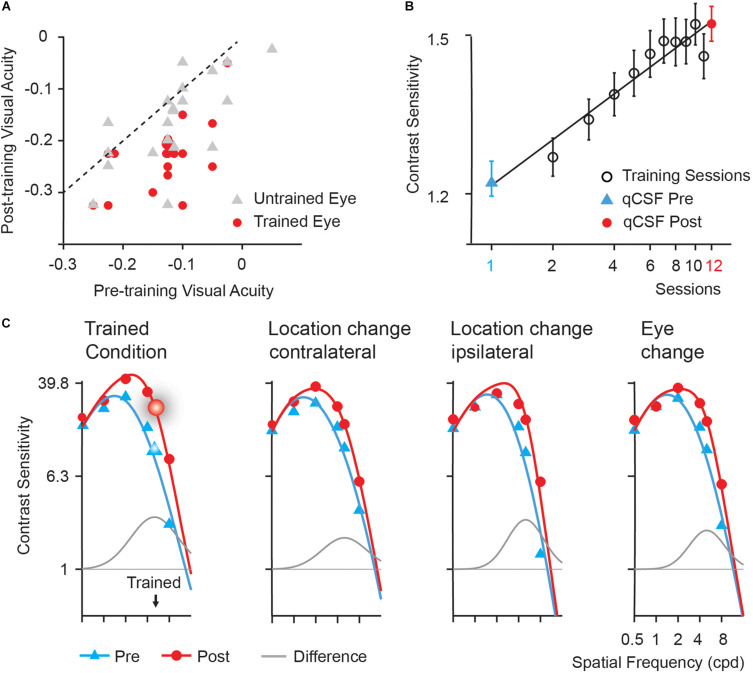
Behavioral results. (A) Post- versus pre-training logMAR visual acuity of trained (red circles) and untrained (gray triangles) eyes. Each symbol represents the data of one subject. The dashed line is the identity line (slope = 1), indicating no improvement. (B) Learning curve. Error bars represent standard errors across subjects. The first (blue triangles) and last data points (red circles) were derived from pre- and post-training CSF measurements in the trained condition, respectively. Black open circle: data from training phase. (C) Pre- (blue curves) and post-training (red curves) CSFs and the difference between the best fitting post- and pre-training CSFs (gray curves) measured in the trained location (the upper left), the upper right (Location change-contralateral) and the lower left (Location change-ipsilateral) visual field location in LE, and the upper left location in RE (Eye change). The enlarged symbols indicate the trained condition (spatial frequency: 5 cpd; location: the upper left; eye: LE) before (blue triangles) and after training (red circles). BW: the bandwidth of perceptual learning.